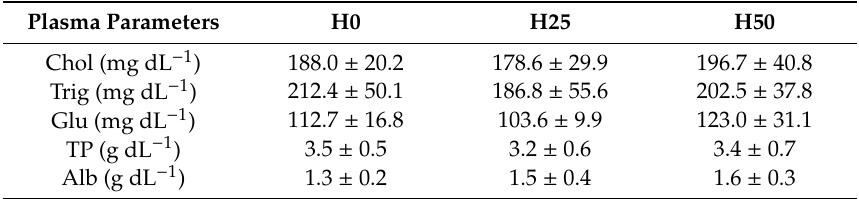
Table 4. Plasma metabolic parameters measured in rainbow trout fed the test diets at the end of the 98-day feeding period.